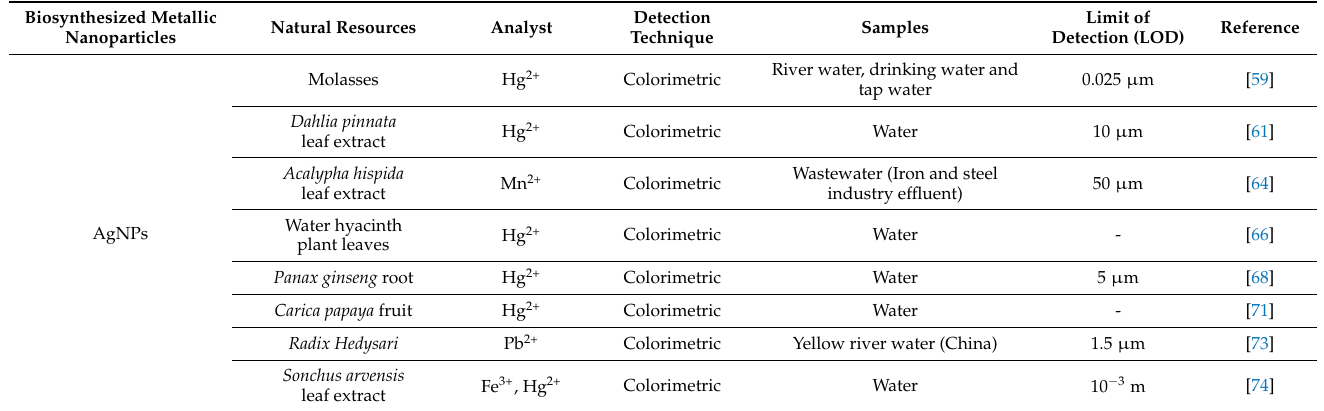
Table 2. Biosynthesis of metallic nanoparticles for identification of heavy metal